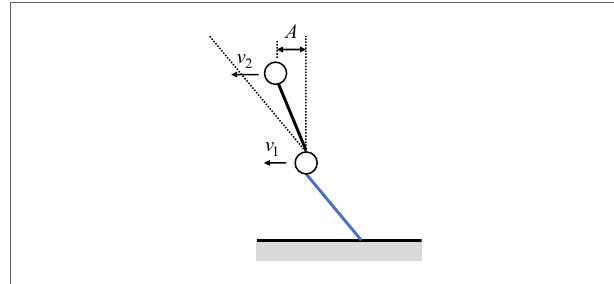
FigUre 5 | simple harmonic vibration of the second-story mass around the center of magnitude A .